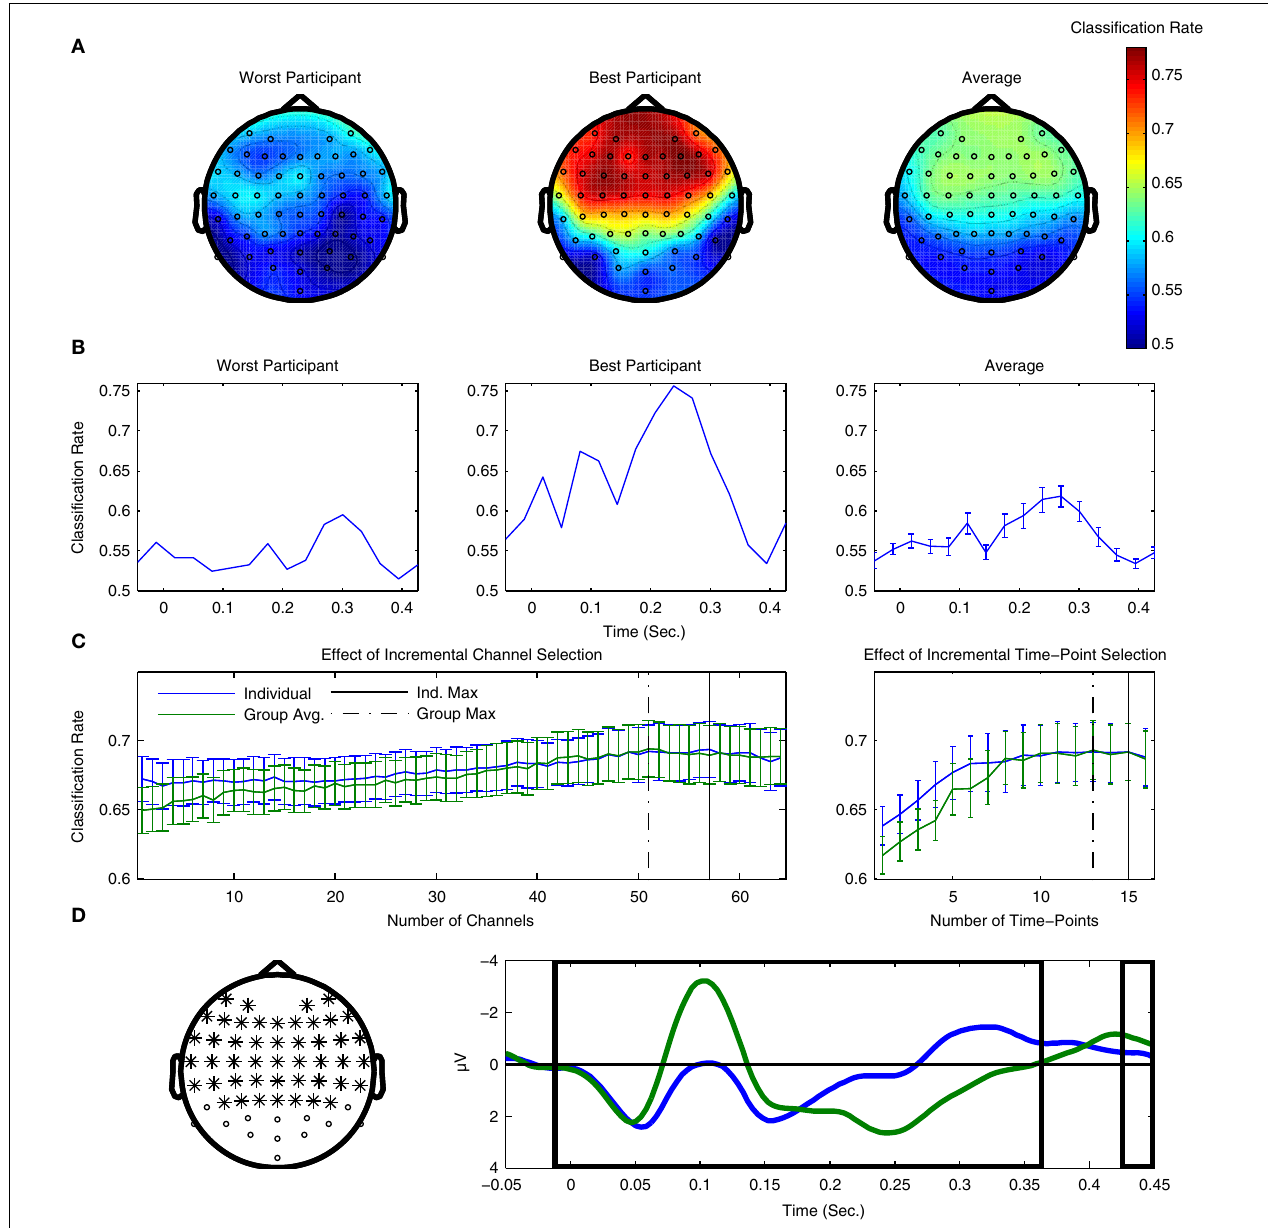
FIGURE 7 | Use of searchlight procedures for spatial and temporal classification of Dataset 1. (A) Classifier performance using individual EEG channels. Cross-validation rates at individual EEG channels are shown for the two participants with the lowest and highest cross-validation rates, as well as the average rates across all participants. The fronto-central electrode locations typically associated with maximal MMN responses are where the highest performance was observed. (B) Classification performance using individual time-points. Performance for the same two participants and the average across participants are shown. Peaks in performance can be seen for both the MMN and P3a component time-ranges, as well as an additional peak near stimulus onset. When comparing the timing of the peaks for the two individual participants, a relative shift in their latencies can be observed. Similar shifts in ERP component latencies are typically associated with individual differences in perceptual discrimination and task performance. (C) Effects of incremental inclusion of channels and time-points based on channels × 16 time points = 1024 dimensions to